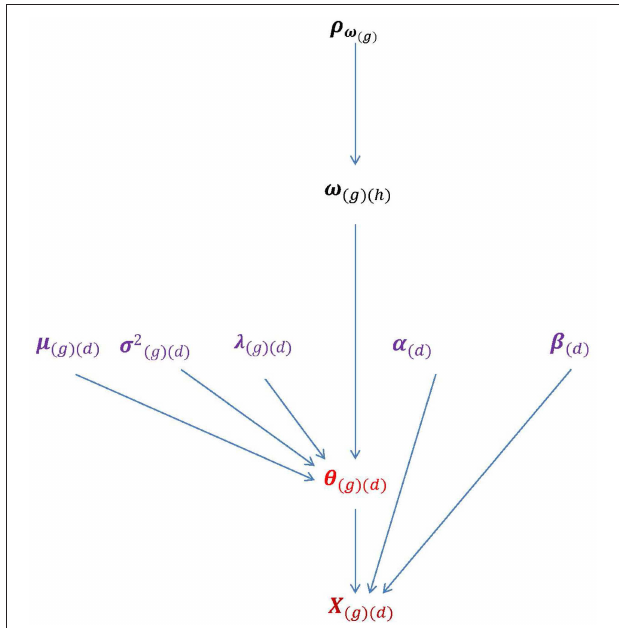
FIGURE 2 | The parameters of the bivariate HO-IRT model for multiple groups. Lower-order trait scores θ ( g )( d ) can be seen as a direct function of higher-order latent traits ω ( g )( h ) and characterized by regression coefficients λ ( g )( d ) that relate θ ( g )( d ) to ω ( g )( h ) as well as by the mean vector and covariance matrices µ ( g )( d ) and σ 2 ( g )( d ) . Item parameters α j ( d ) and β j ( d ) are also